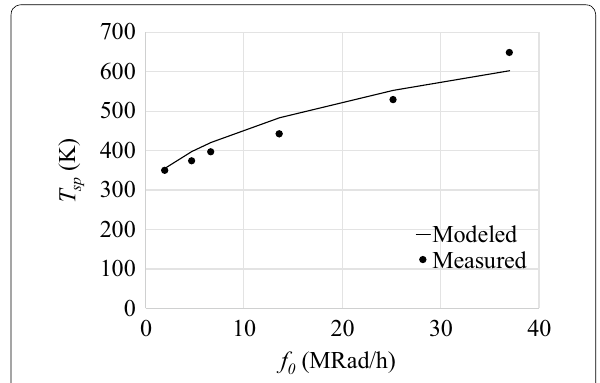
Fig. 5 T sp measured by Sanchez et al. (2018) vs. modeled by